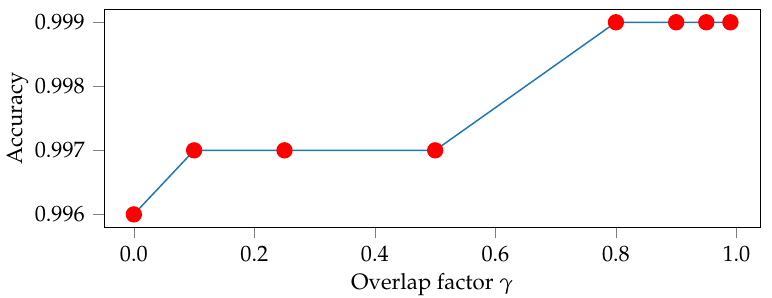
Figure 8. Five-fold cross validation test accuracies for various input window lengths T .